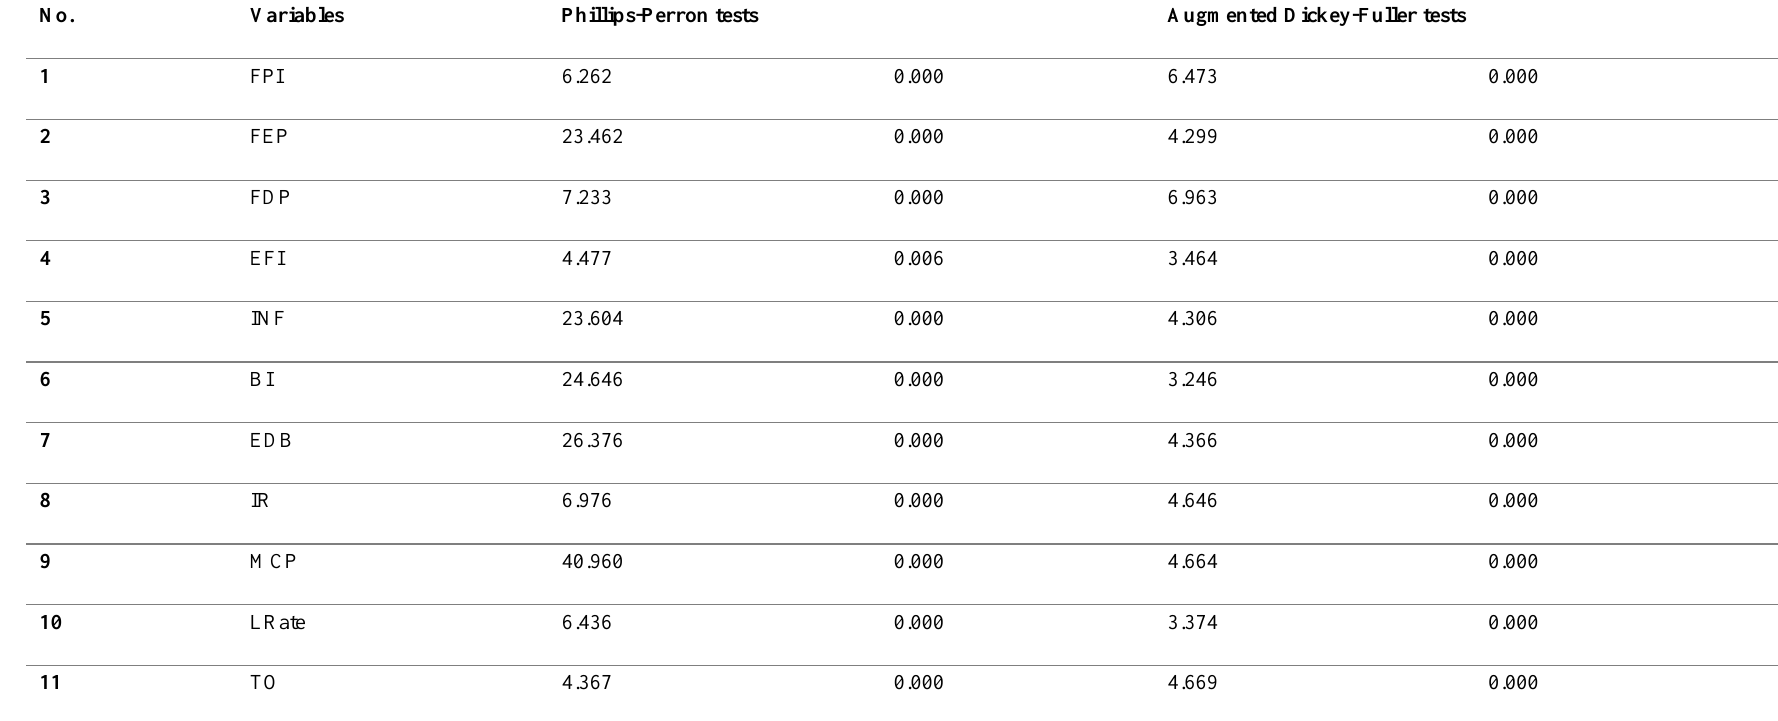
Table 2: Phillips-Perron tests and Augmented Dickey-Fuller tests for Unit